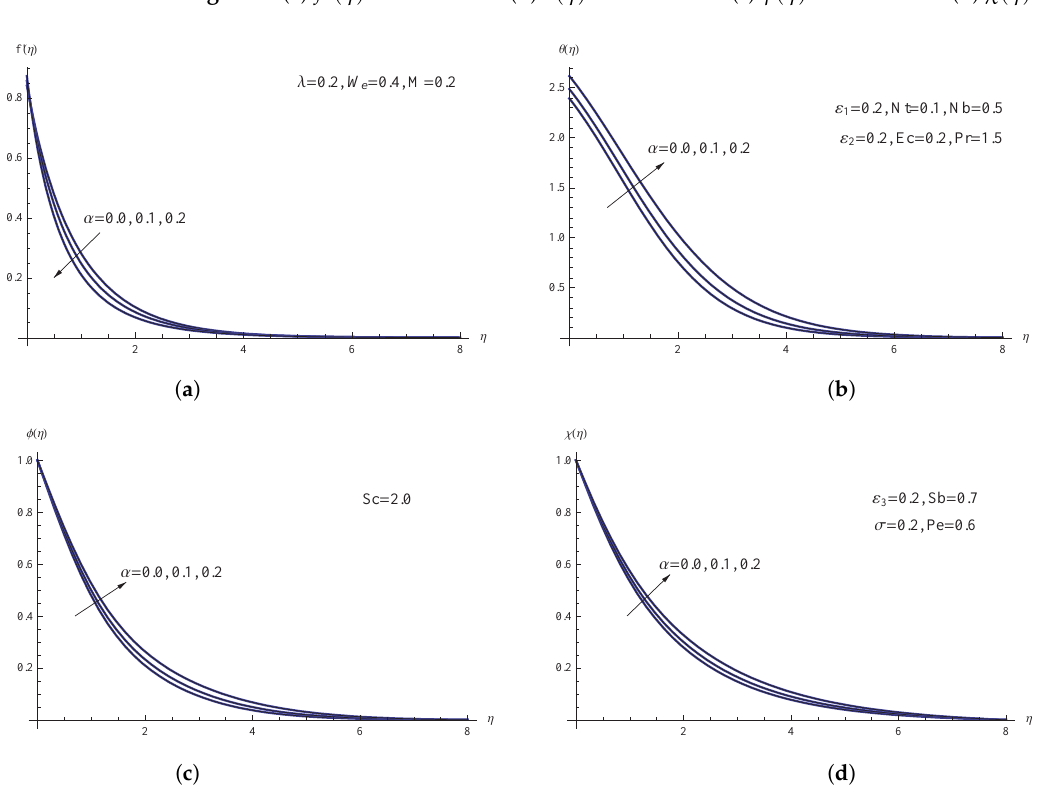
Figure 4. ( a ) f (cid:48) ( η ) for various α . ( b ) θ ( η ) for various α . ( c ) φ ( η ) for various α . ( d ) χ ( η ) for various α